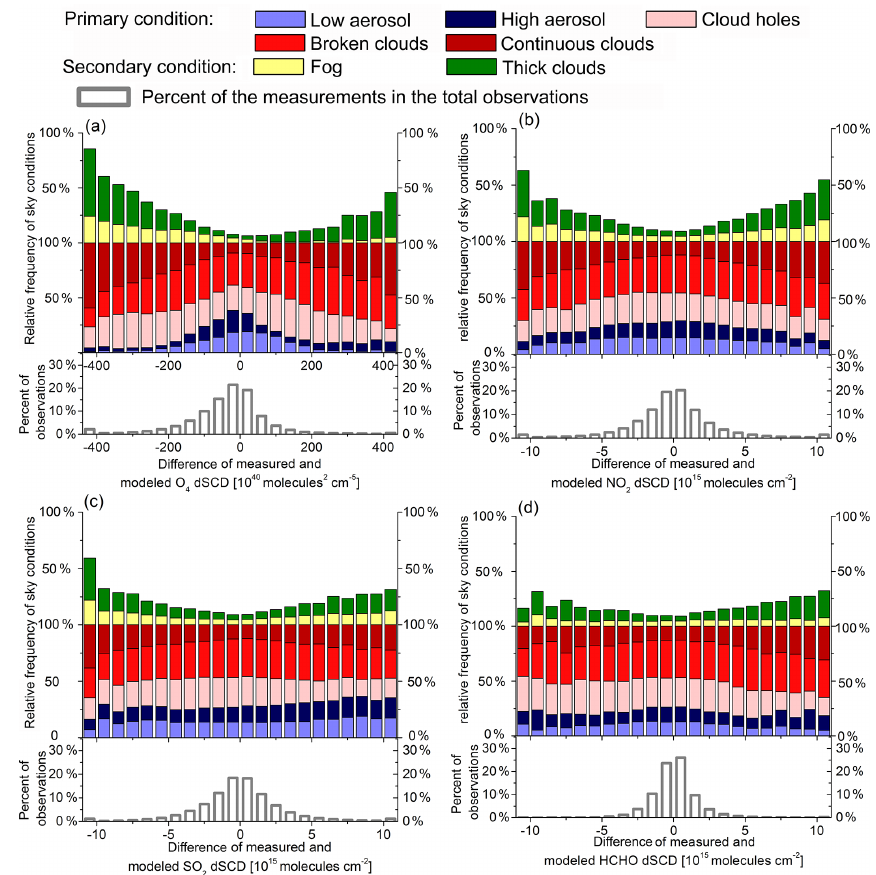
Figure 7. Histograms of the differences between the measured and modelled dSCDs of O 4 (a) , NO 2 (b) , SO 2 (c) and HCHO (d) for all elevation angles. The colour bars show the relative frequencies of the different sky conditions for each bin (top panels). The grey hollow bars (bottom panels) represent the relative frequencies of the number of measurements compared to the total number of